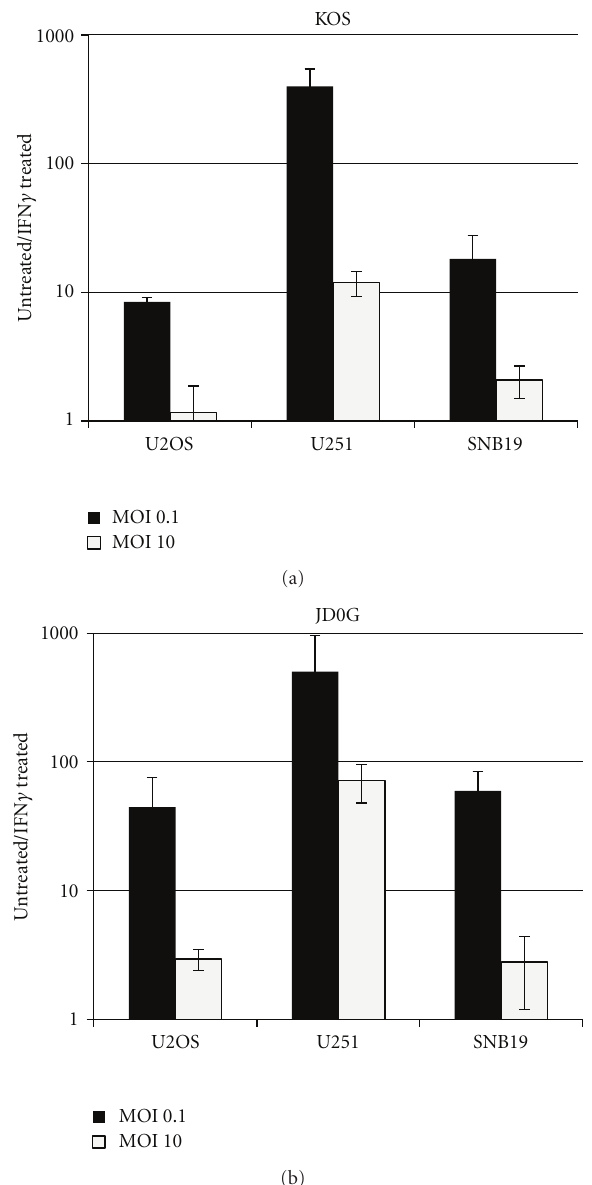
Figure 3: IFN γ treatment of glioblastoma cells results in a decrease in virus yield in an MOI-dependent manner. U251 and SNB19 cells were pretreated or mock treated with IFN γ (500 U/mL) 24h prior to infection with either KOS or JD0G at an MOI of 0.1 (a) or 10 (b), and the supernatants were titered at 24 hpi. The data present the average of two independent infections, and the error bars represent the standard deviation; these data are representative of replicate